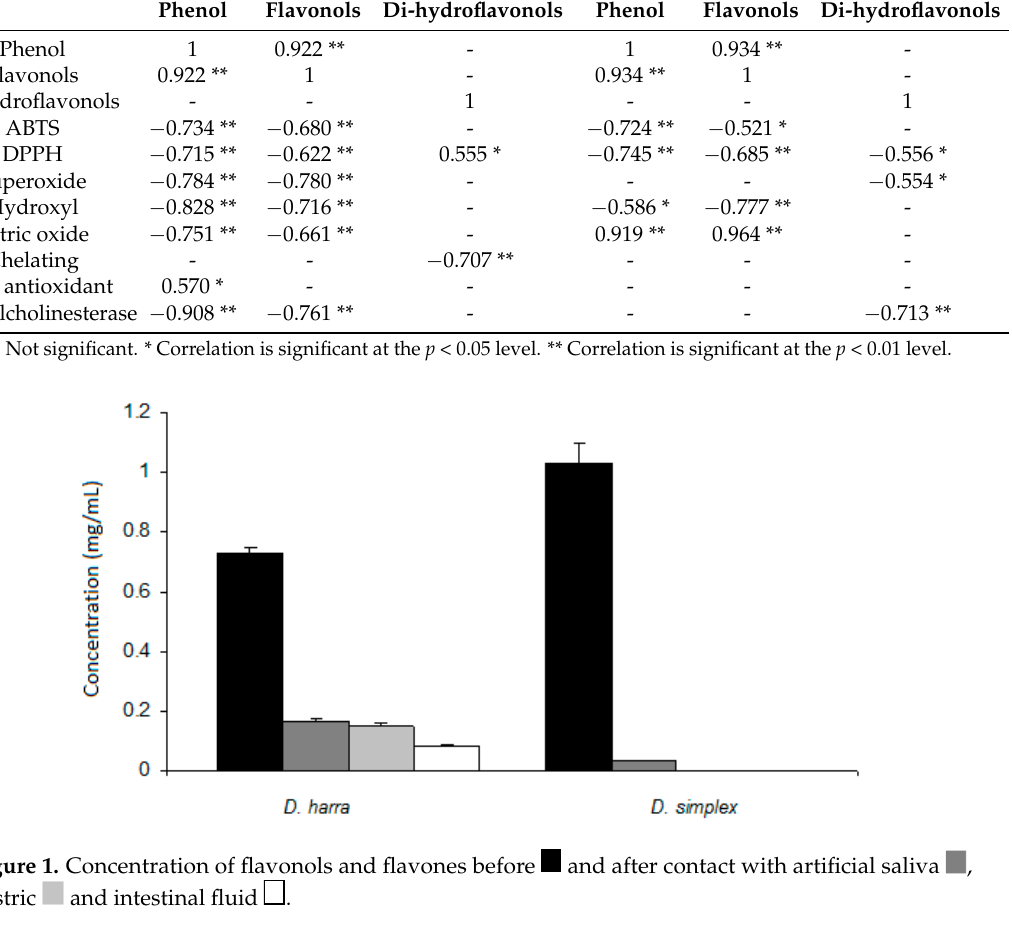
Figure 1. Concentration of flavonols and flavones before and after contact with artificial saliva , gastric and intestinal fluid .